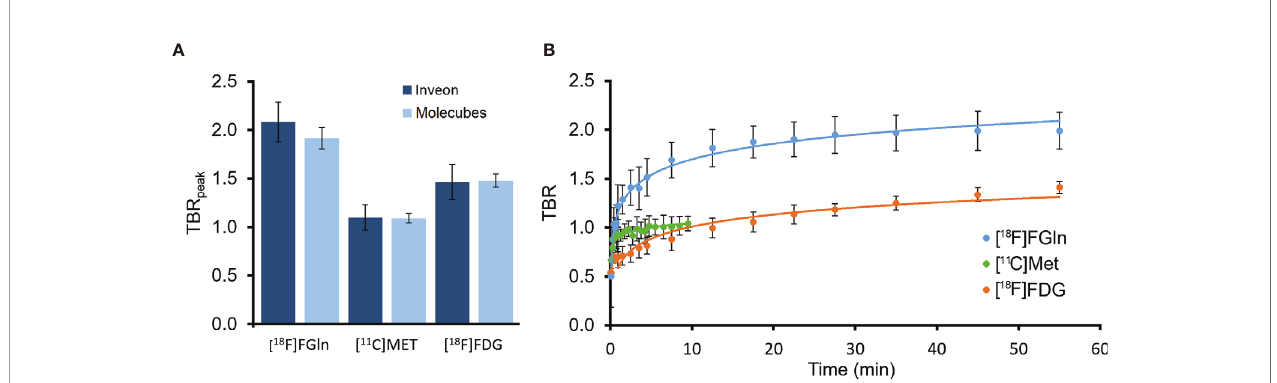
FIGURE 4 | (A) Average peak-TBR levels reached during PET imaging for each radiopharmaceutical, separated by PET camera used Inveon [ 18 F]FGln (n = 9), Molecubes [ 18 F]FGln (n = 4), Inveon [ 11 C]Met (n = 8), Molecubes [ 11 C]Met (n = 4), Inveon [ 18 F]FDG (n = 4), and Molecubes [ 18 F]FDG (n = 3). (B) Both-camera